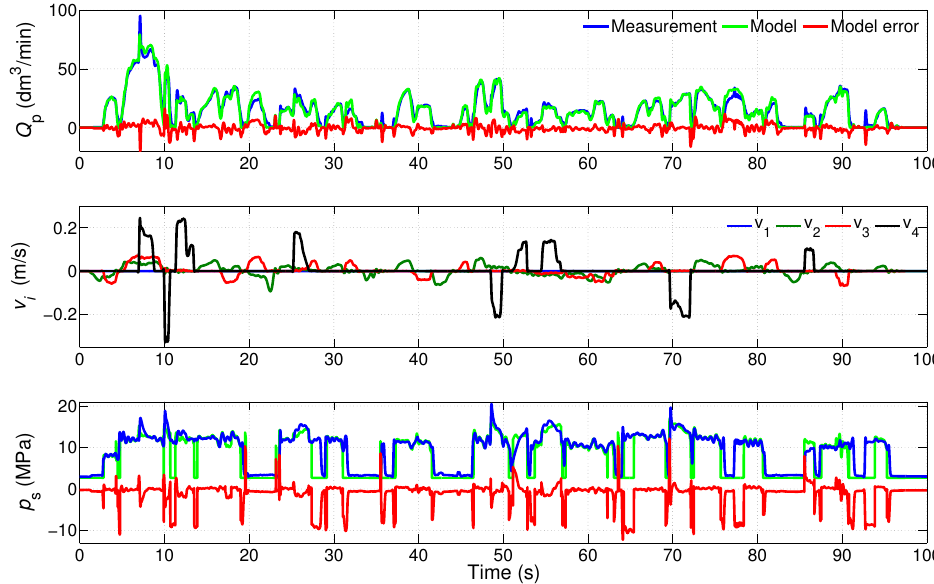
Figure A3. Pump flow rate Q p (dm 3 /min), cylinder velocities v i (m/s) and pump supply pressure p s (MPa) as a function of time